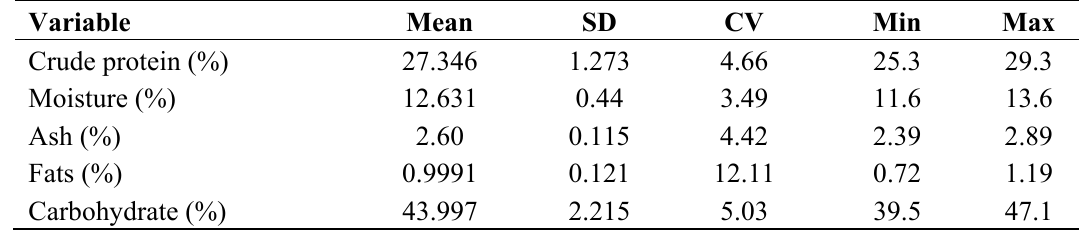
Table 4. Mean, minimum values, maximum values, standard deviation (SD) and coefficient of variability (CV) of proximate analysis in lentil genotypes (on dry weight basis).